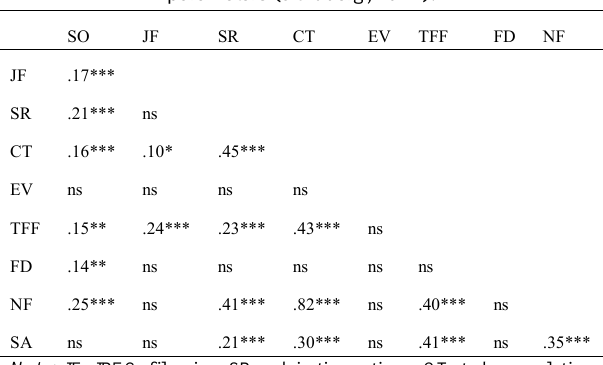
Table 1. Correlation matrix among selected eye movement parameters (Goldberg,